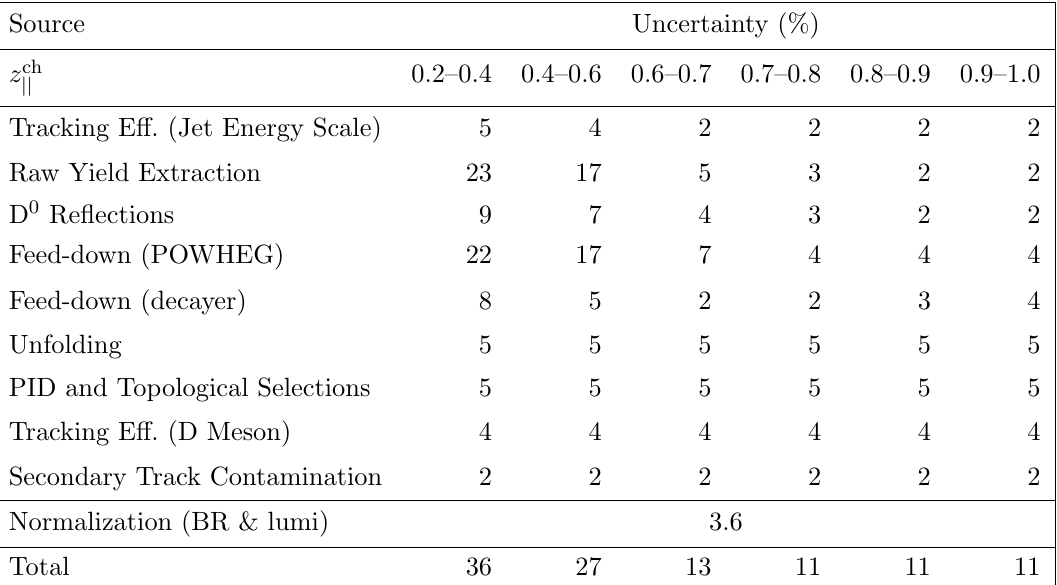
Table 2 . Summary of systematic uncertainties as a function of z ch